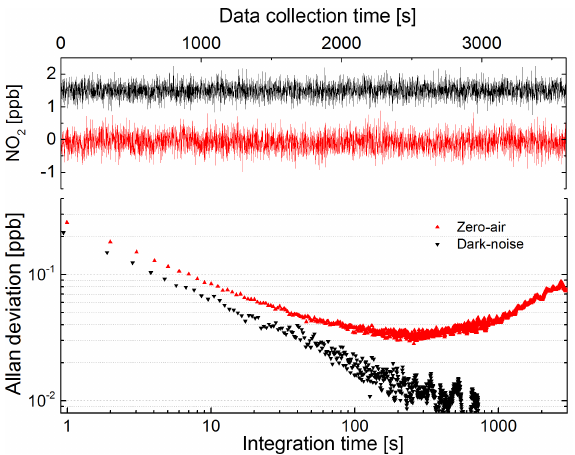
Figure 6. Scatter plot of NO 2 measurement (1min averages) in am- bient air using QCLAS and CLD techniques. The linear fit to the data (red line) has a slope 0.83 ± 0.004, intersect − 0.49 ± 0.04, (er- rors are given in 1 σ ) and an R 2 of